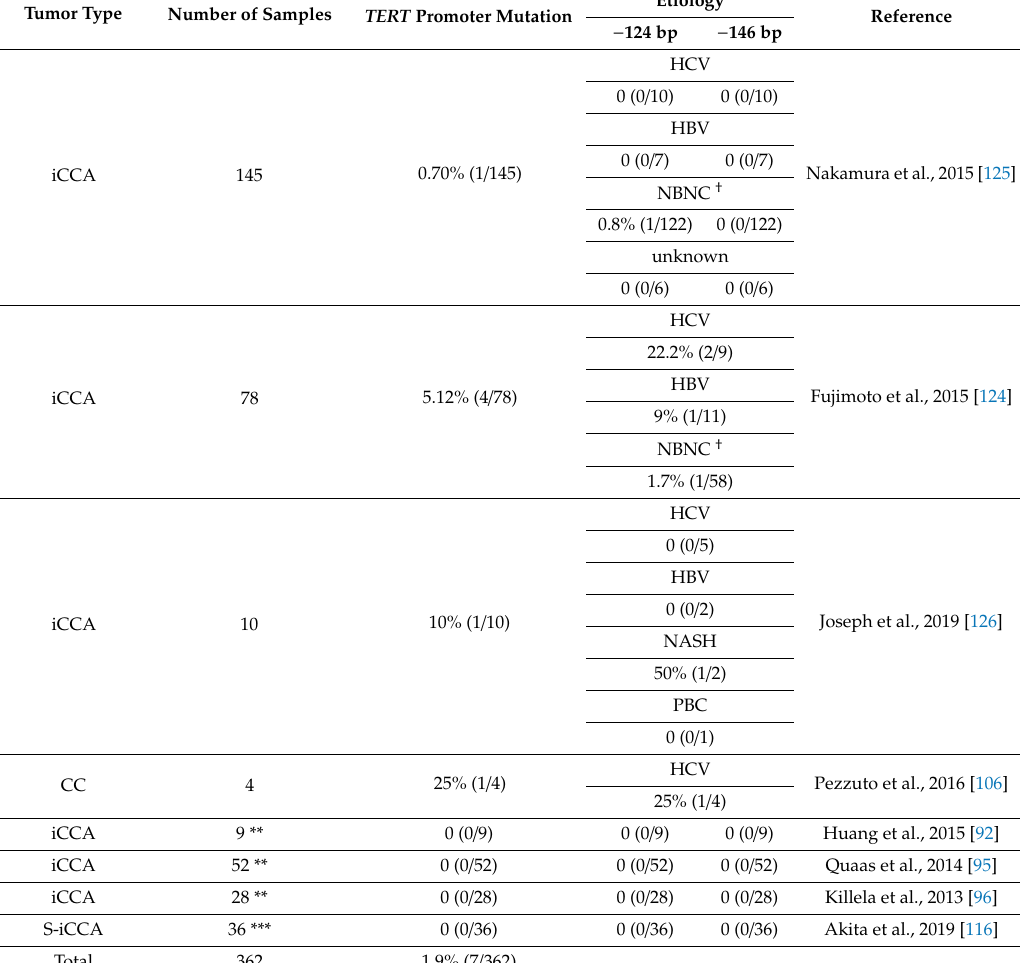
Table 2. TERT promoter mutations in intrahepatic cholangiocarcinoma